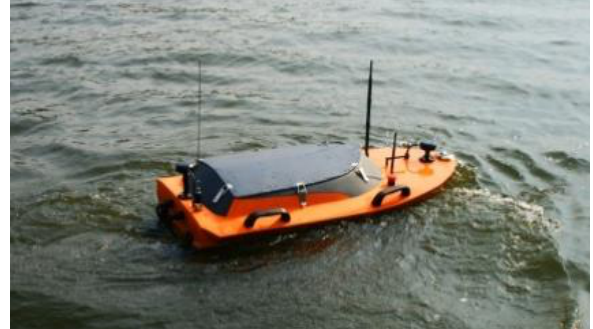
Figure 6. Geomar boat survey (Geomar,